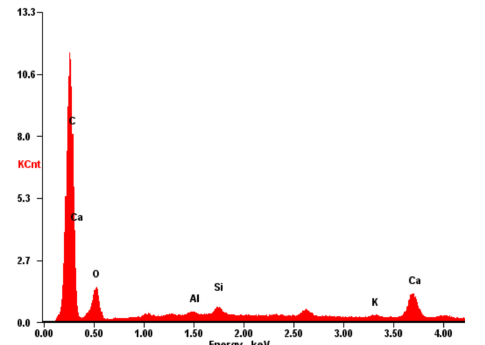
Figure 4. MO image of the textolite material’s surface with initial degradation effects (40 times magnification). There was a visible change in the colour of the material, indicating the process of carbonisation of the organic resin. Small fragments of the fibreglass textile support began to appear on the surface (marked in circles).